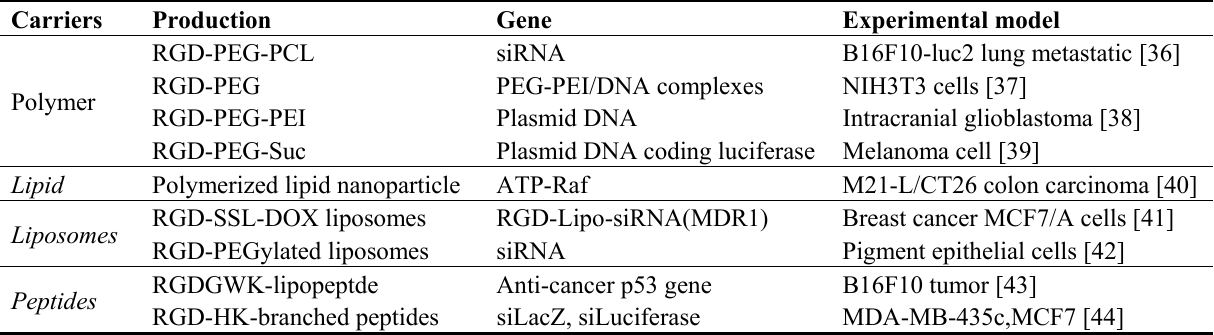
Table 1. RGD-modified non-viral carries for gene delivery [7].